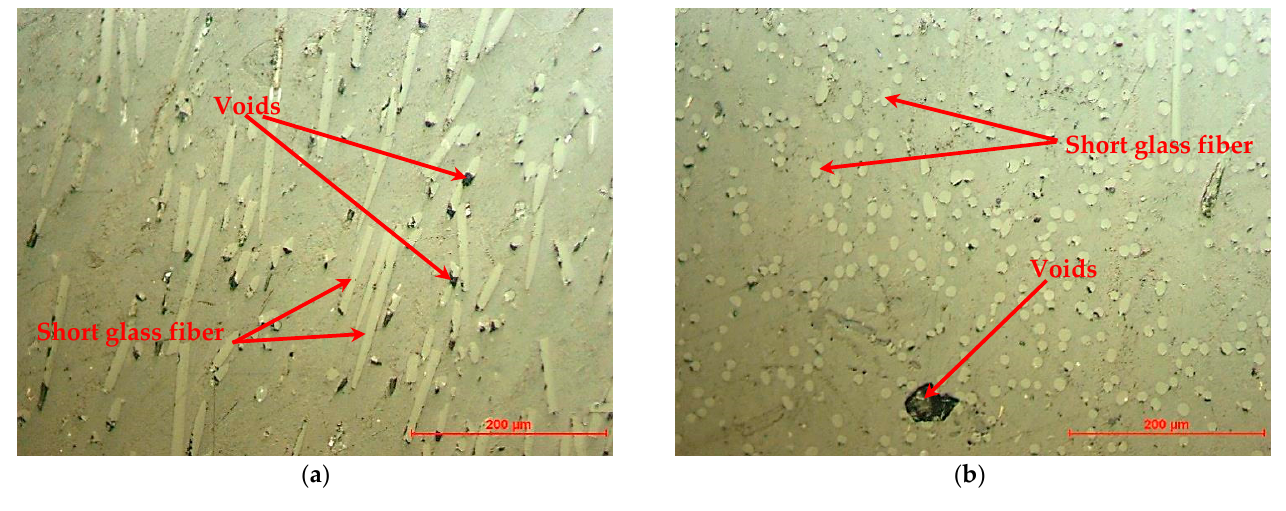
Figure 8. Microscopic analysis of the landing gear made of PLA GF: ( a ) longitudinal section (100×);